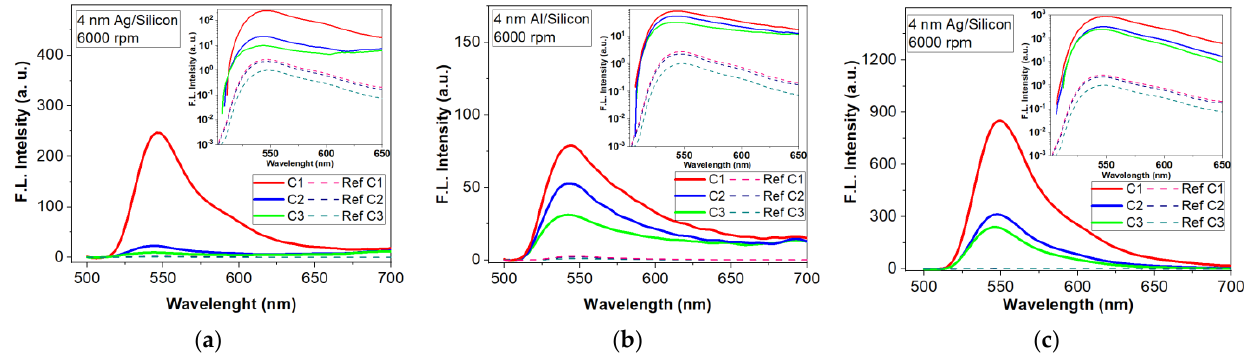
Figure 8. Florescence intensity enhancement by a 4 nm metallic (mass equivalent) films on silicon substrate (inset are the FLEN with logarithmic y scale): ( a ) Au meta-atoms; ( b ) Al meta-atoms; ( c ) Ag meta-atoms.